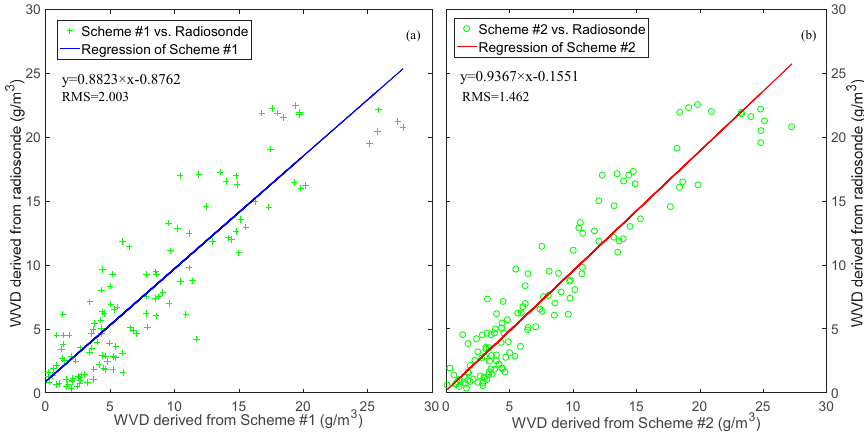
Figure 9. Linear regression of water vapor density from radiosonde and two schemes. ( a ) and ( b ) represent the regression results of Scheme #1 and #2, respectively.